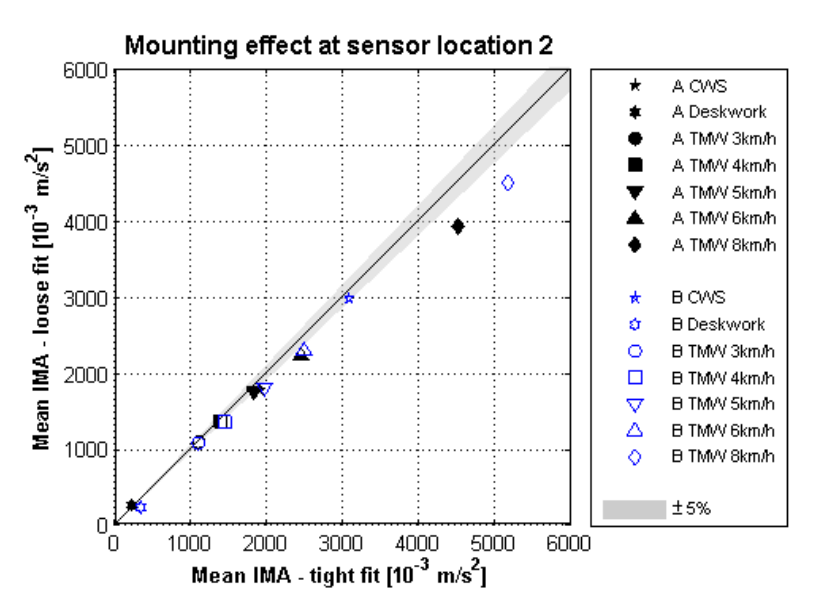
Figure 9. Effect of mounting on IMA values for various activities measured at sensor location 2, for two subjects (A and B, n = 2). IMA values measured with the Exilim pouch (loose fit) vs . the more securely fitted